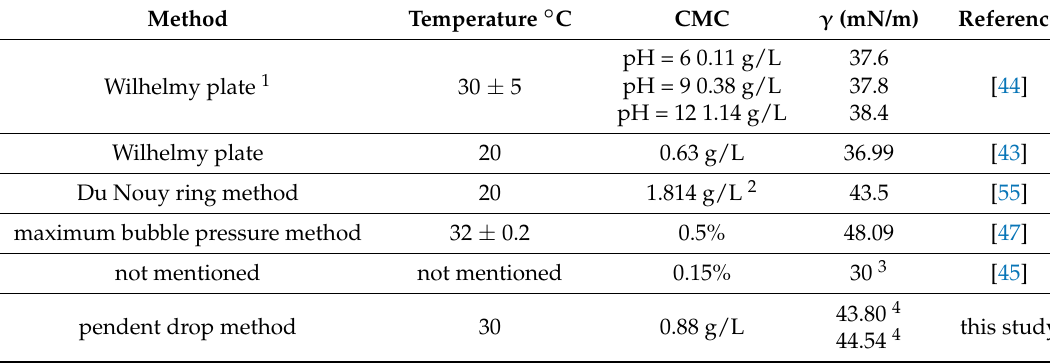
Table 3. Surface properties for tea saponins using different measurement